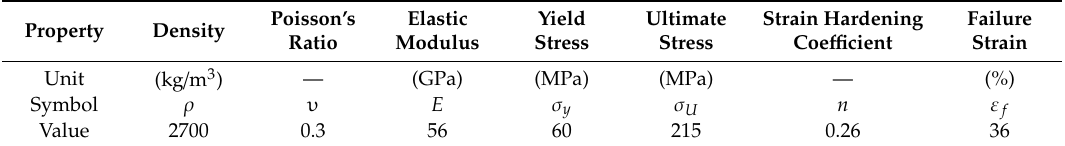
Table 2. Mechanical properties of aluminium